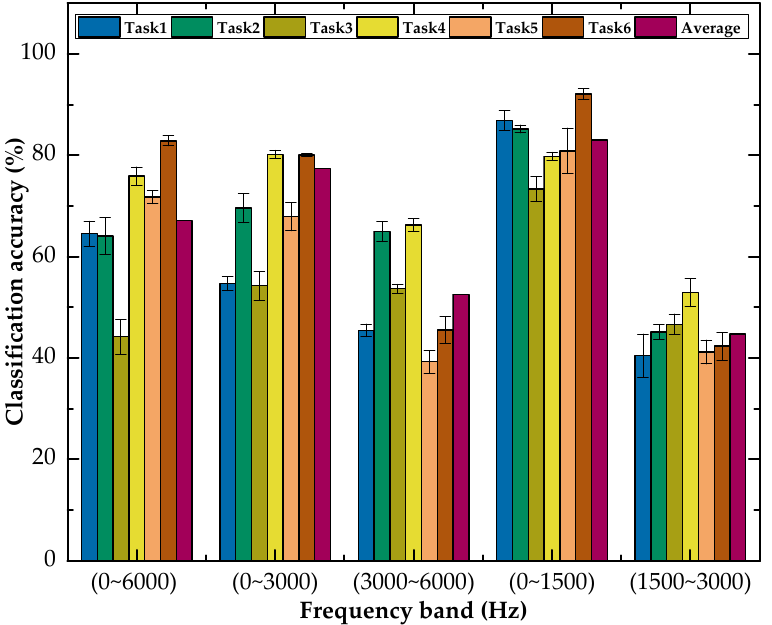
Figure 8. Classification accuracy (%) on MTF-DDAN in different frequency bands.